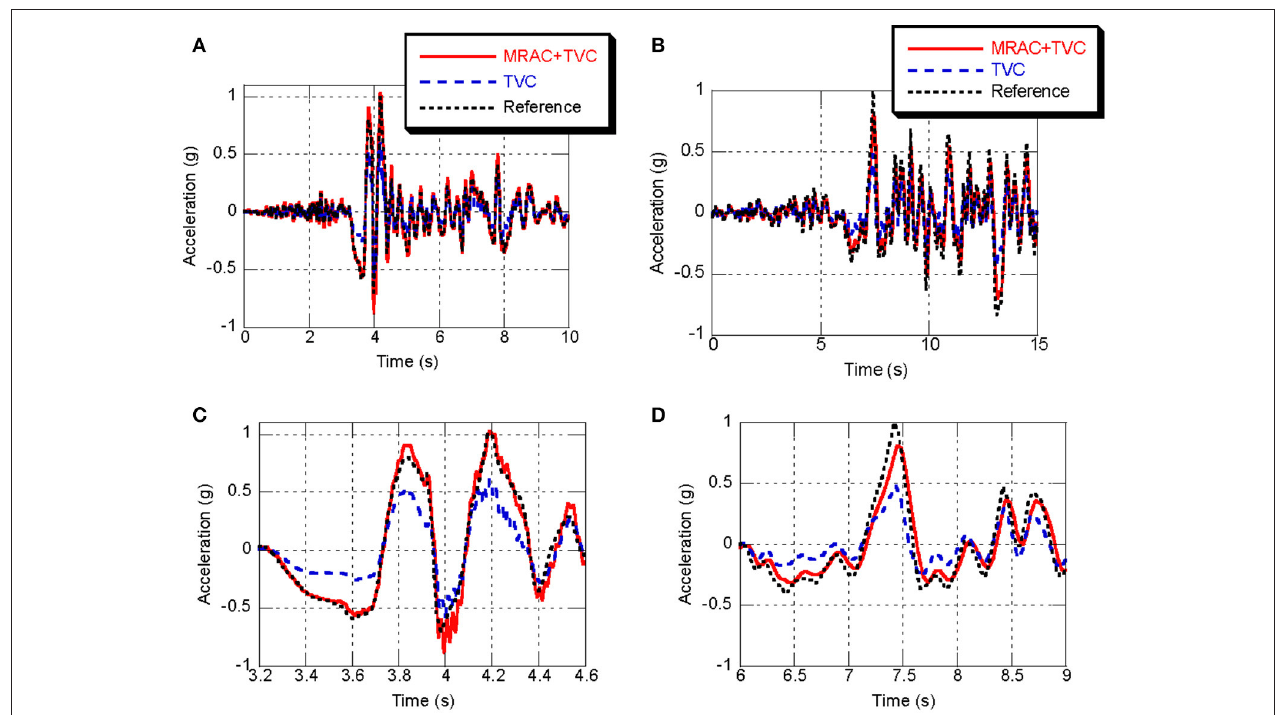
FIGURE 6 | Comparison of table performance in time domain. (A,C) Wide and narrow views of acceleration tracking for the Northridge earthquake. (B,D) Wide and narrow views of acceleration tracking for the Taft earthquake.